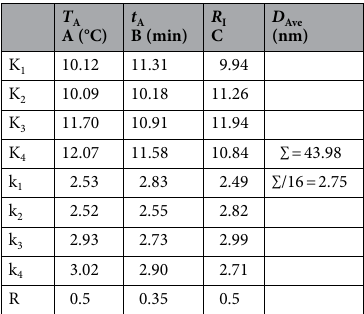
Table 8. The range analysis of average pore diameter.